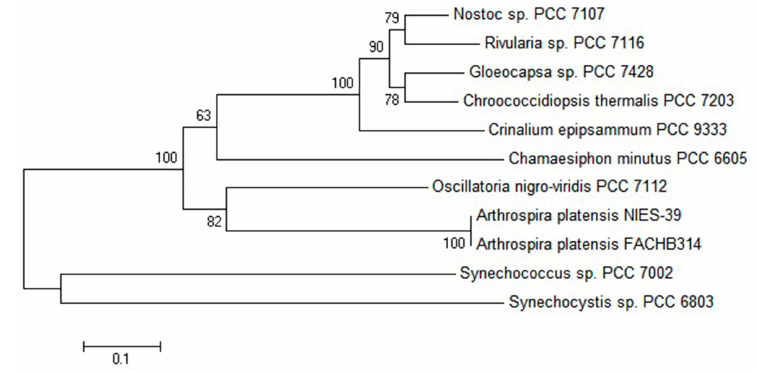
Figure 1. Phylogenetic analysis of CpcU amino acid sequences. Numbers at the nodes represent the bootstrap values. The evolutionary distance between the groups is indicated by the scale (0.1 = 10% differences). The sequences of CpeS taken from GenBank are as follows: A. platensis NIES-39 (NC016640.1), Chamaesiphon minutus PCC 6605 (CP003 600.1), Oscillatoria nigro-viridis PCC 7112 (CP00361 4.1), Nostoc